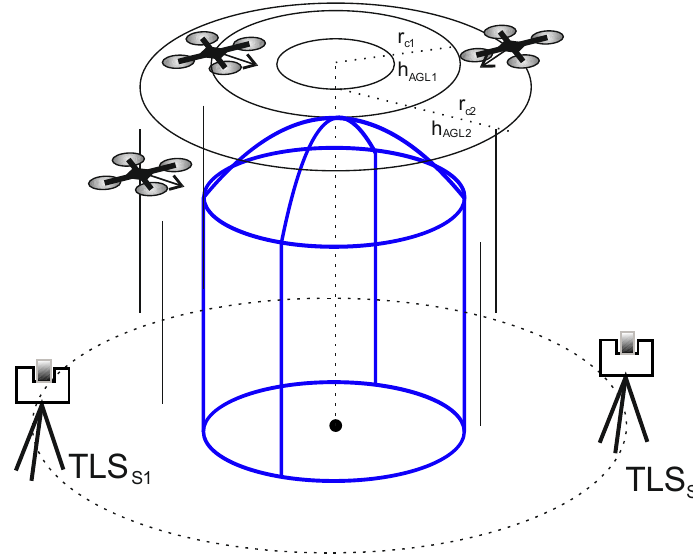
Figure 4. TLS and UAV data acquisition diagram for high structures.